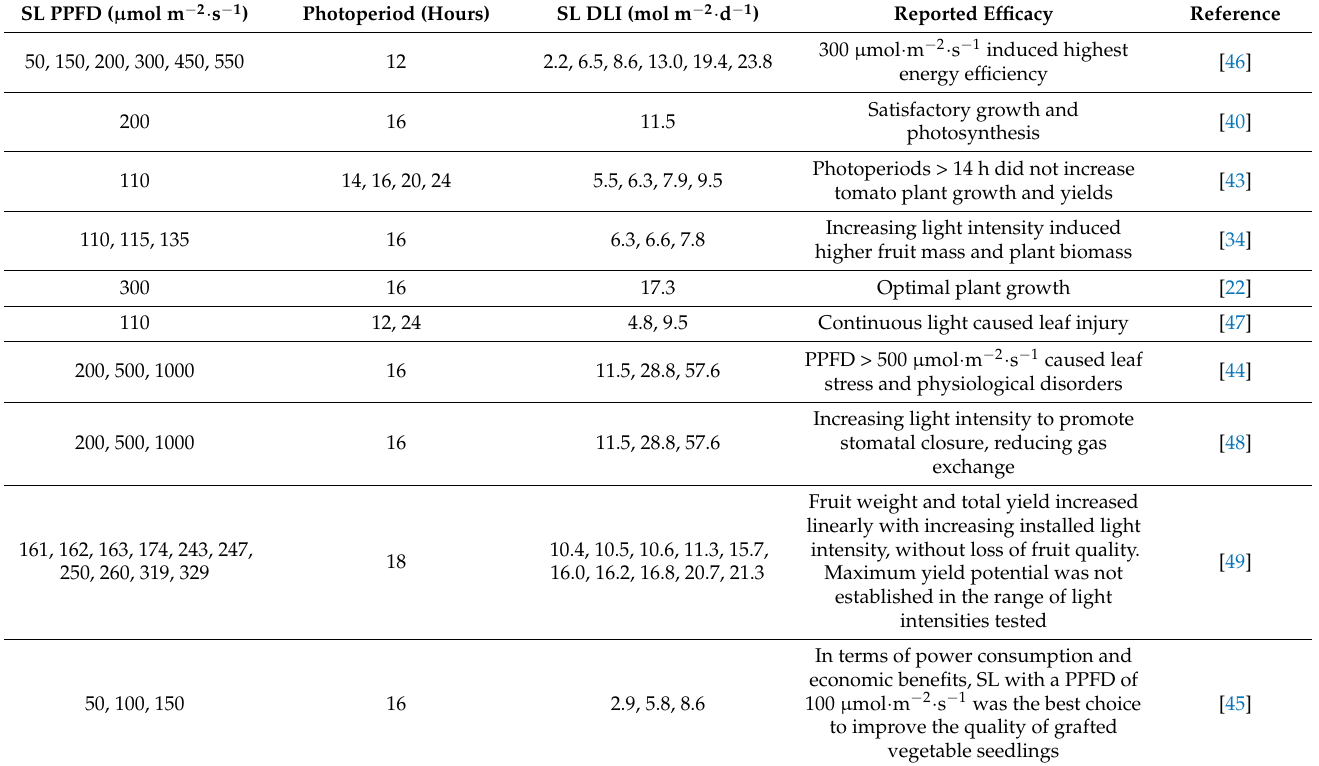
Table 5. Overview of experiments on tomato growth and production applying different PPFDs and/or different photoperiods. SL PPFD ( µ mol m − 2 · s − 1